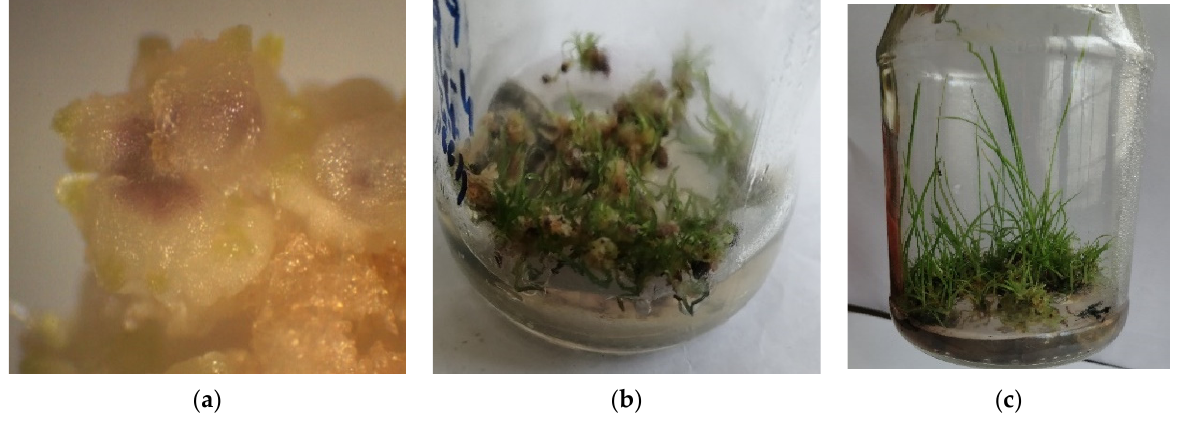
Figure 8. ( a ) Stereomicrograph showing shoot induction from callus culture in YT-53 on MS + 2 mg L − 1 Kinetin (20 × ), ( b ) shoot induction in callus of YT-53 on MS + 2 mg L − 1 Kinetin after 10 days (1 × ), and ( c ) shoot induction in callus YT-53 on MS + 2 mg L − 1 Kinetin after 20 days of inoculation (1 × ). In CP-77400 the greatest number of shoots in the minimum number of days (8) from 0.25 g callus was achieved on MS media provided with MS + 1 mg L − 1 BAP(T1). No